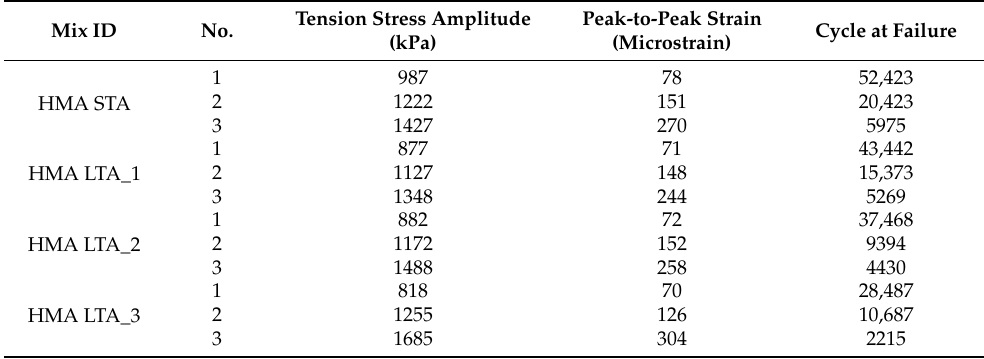
Table 5. Fatigue cracking performance test results according to the aging of HMA and